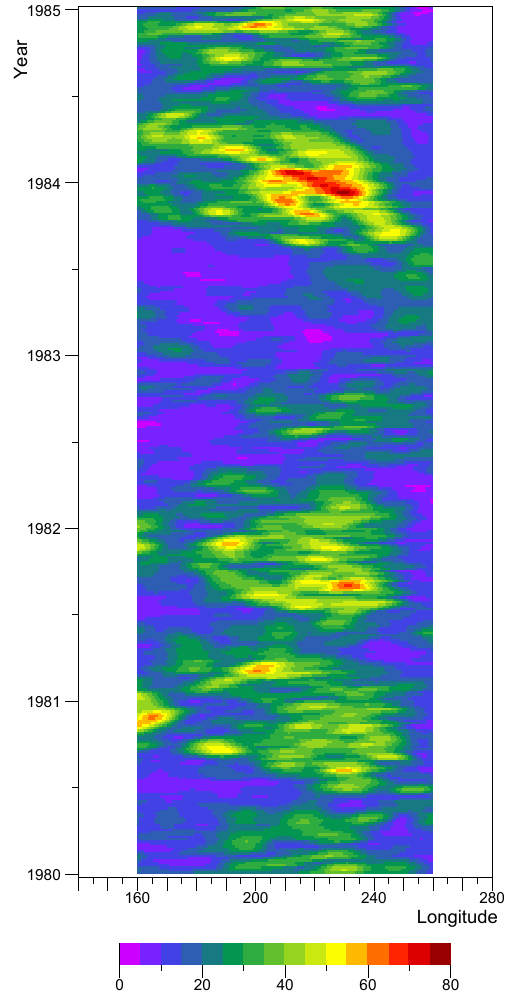
Figure 15. The surface current at the Equator (ms − 1 ), averaged between 1 ◦ S and 1 ◦ N. Negative values correspond to the normal westward-flowing Equatorial